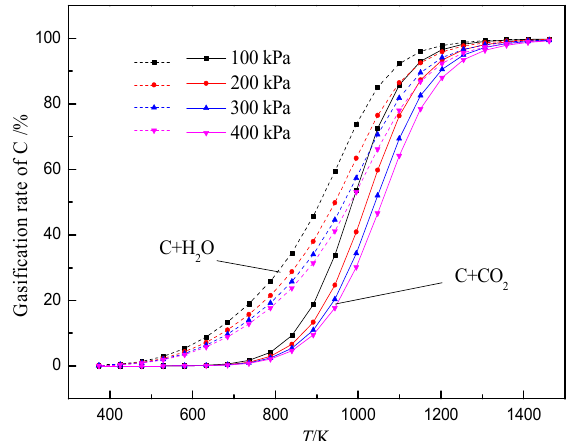
Figure 3. Relationships between gasification rate and temperature of carbon reacting with CO 2 and H 2 O, adopted from [55], with permission from Elsevier 2018.